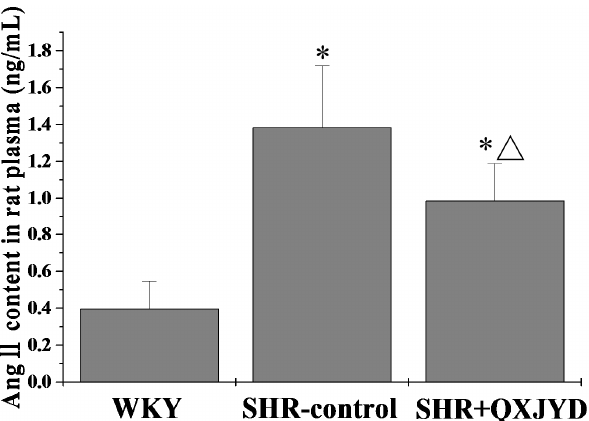
Figure 6. Effect of QXJYD treatment on plasma Ang II production. The level of Angiotensin II (Ang II) in plasma from each group ( n = 10) was examined by ELISA. All values were represented as mean ± SD; * p < 0.01 compared to WKY group, Δ p < 0.05 compared to SHR-control group.